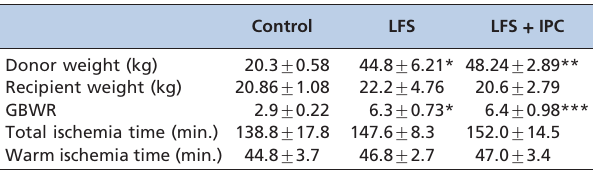
Table 2 - Anthropometric data and transplant characteristics of the groups (mean ¡